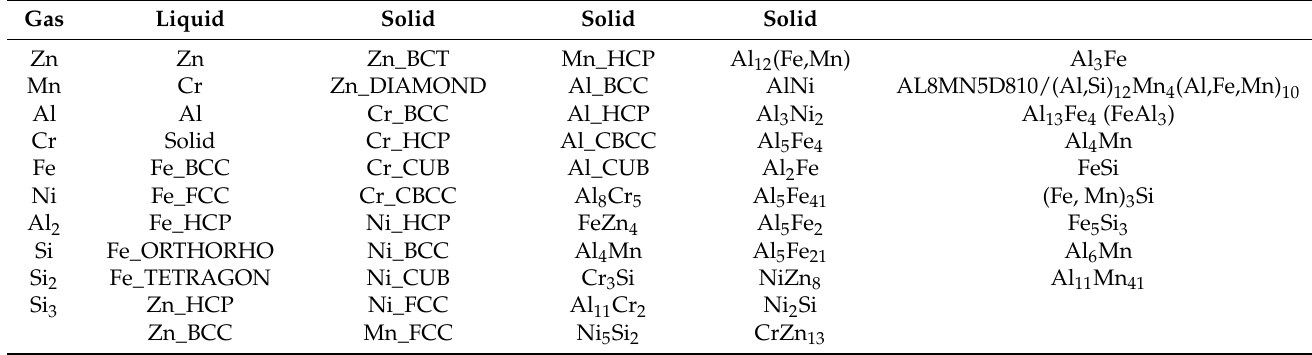
Table 2. Thermodynamic stable phases (products) that were utilized for FactSage